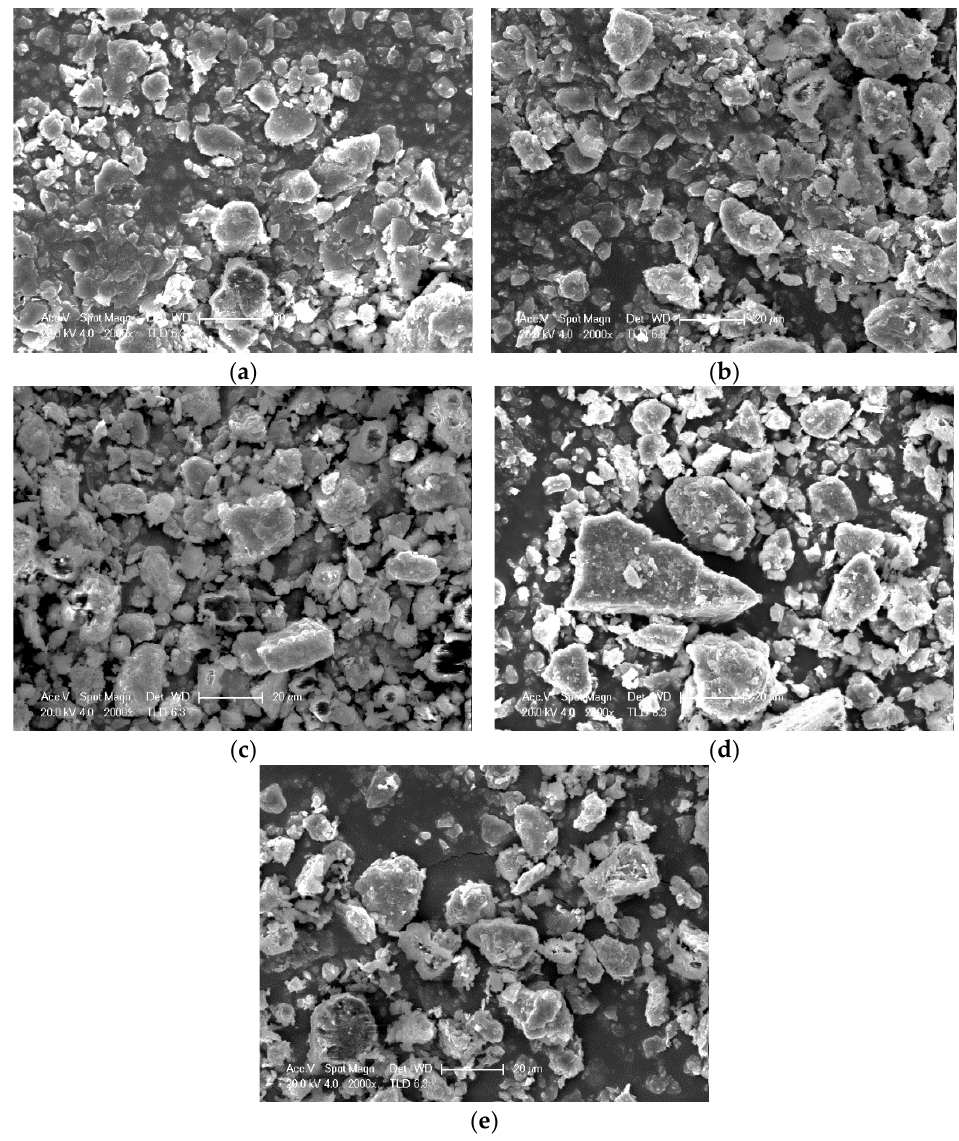
Figure 6. Microstructure of samples under different recycled fine aggregate contents: ( a ) 10% recycled fine aggregate; ( b ) 20% recycled fine aggregate; ( c ) 30% recycled fine aggregate; ( d ) 40% recycled fine aggregate; ( e ) 50% recycled fine aggregate.